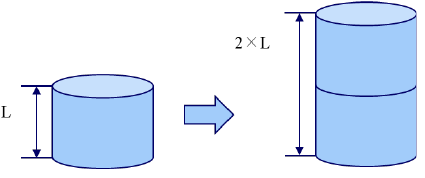
Figure 7. Design concept of DWM with an increased stack length.